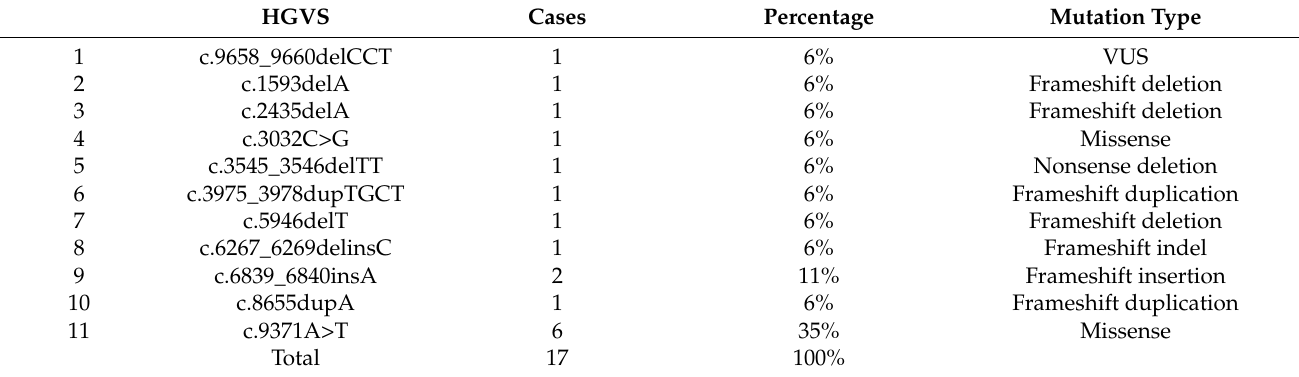
Table 8. BRCA2 mutations (according to the HGVS) and their links to OC in the analyzed group. HGVS